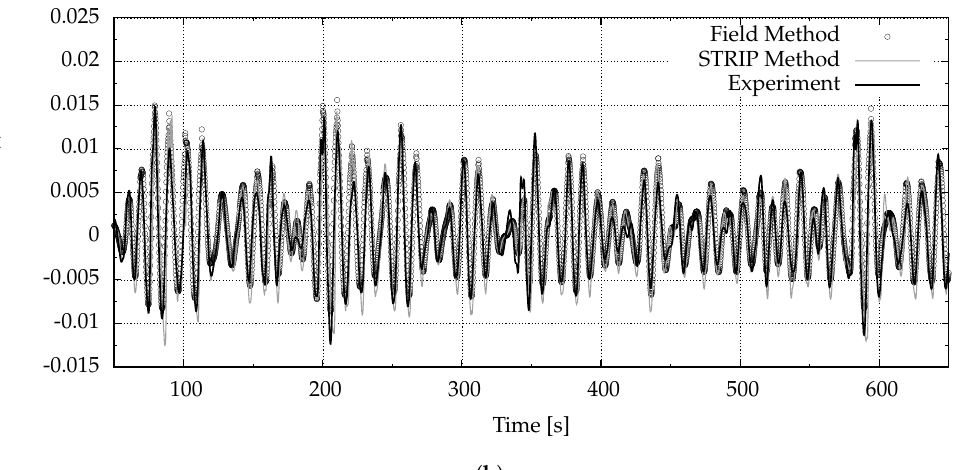
Figure 15. Cruise ship: comparison of time histories obtained with field method and experiments for ( a ) the free surface elevation. The lower figure ( b ) shows the field method and strip method computed vertical bending moment amidships in comparison with model test results.